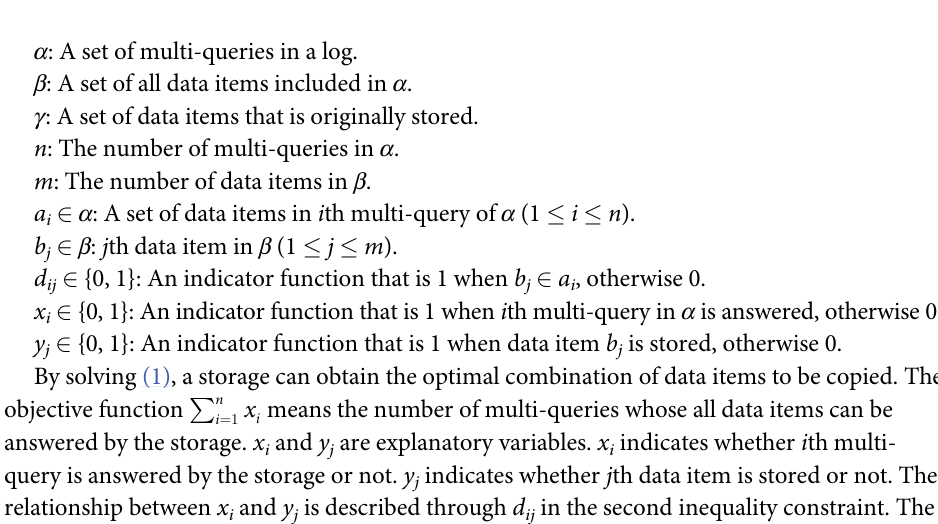
Fig 5. An example of maximizing the number of multi-queries in a log that all queries in the multi-query can be answered by single storage.